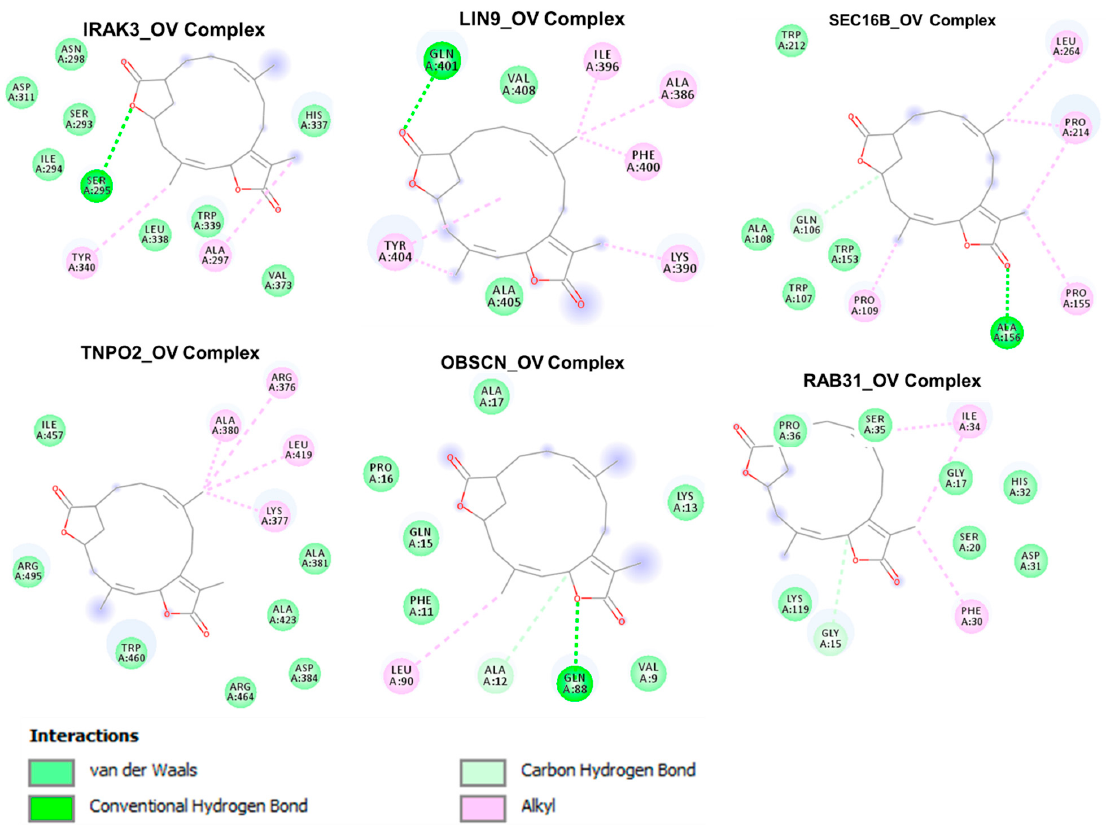
Figure 8. Two dimensional (2D) representation of the docking profile of ovatodiolide (OV) with the crystal structures of the cancer hub genes RAB31 (PDB:2fg5), IRAK3 (PDB:6ruu), OBSCN (PDB:2e01), LIN9 (PDB:6c48), TNPO2 (PDB:2z5j), and SEC16B (PDB:3mzk) . Each complex represents the interaction of the best docking pose between the receptor and the ligand. Table 3. Docking profile of ovatodiolide with the cancer hub